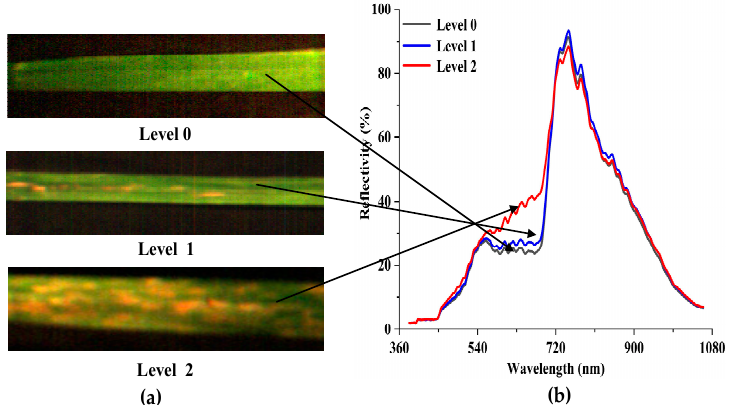
Figure 5. ( a ) False-color composite image showing the three levels and ( b ) Savitzky–Golay (S-G) filter-smoothed data.